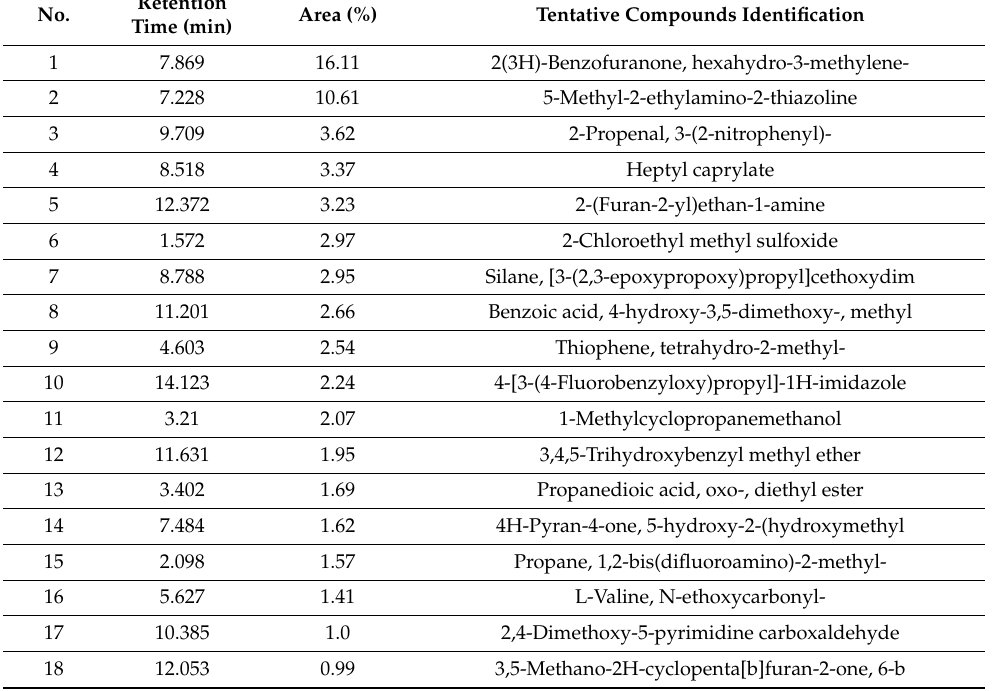
Table 1. Gas chromatography–mass spectrometry analysis of tested manuka honey samples.